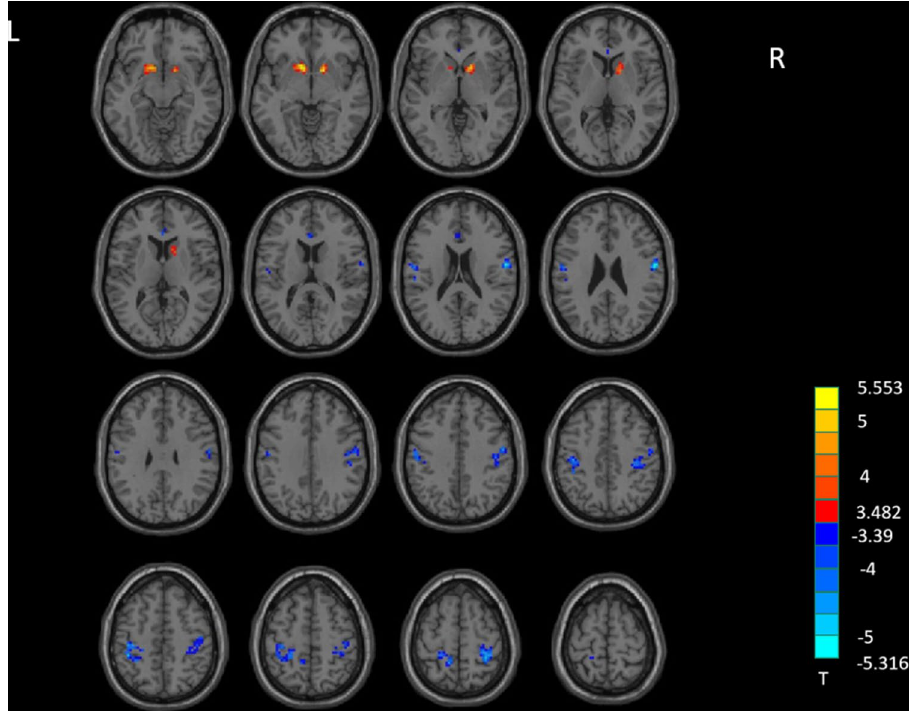
Figure 2. ReHo analysis. Two-sample t-test results are presented, voxel level p < 0.001, cluster level p < 0.05, two-tailed, voxel size > 29, corrected by GRF. Area in blue with significantly decreased ReHo value; area in yellow and red with significantly increased ReHo value. Created with DPABI_V4.3_200401 (http:// rfmri. org/ dpabi).